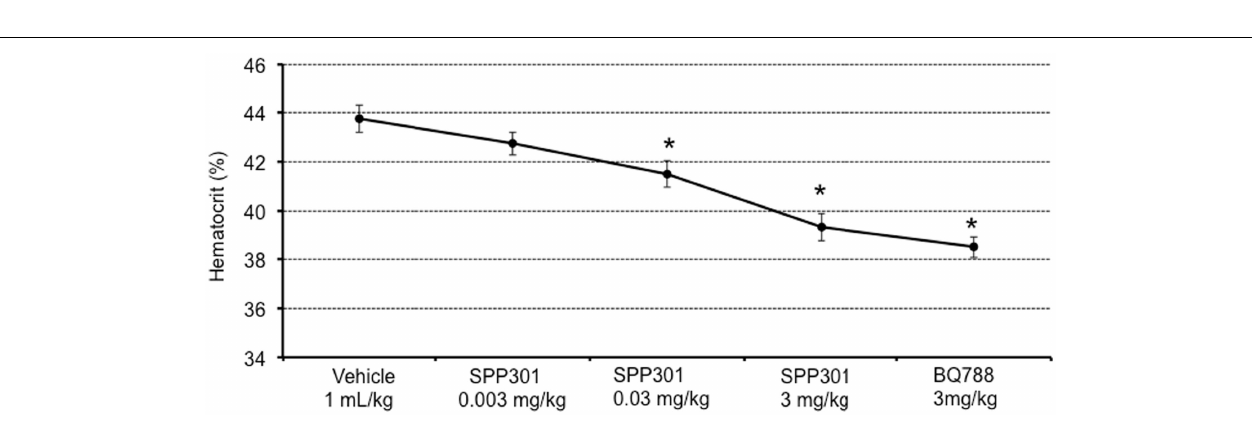
collecting duct-specific ET A receptor knockout decreases renal sensitivity to AVP (Ge et al., 2005). These findings suggest that ET B receptor activation in the collecting duct has diuretic effects